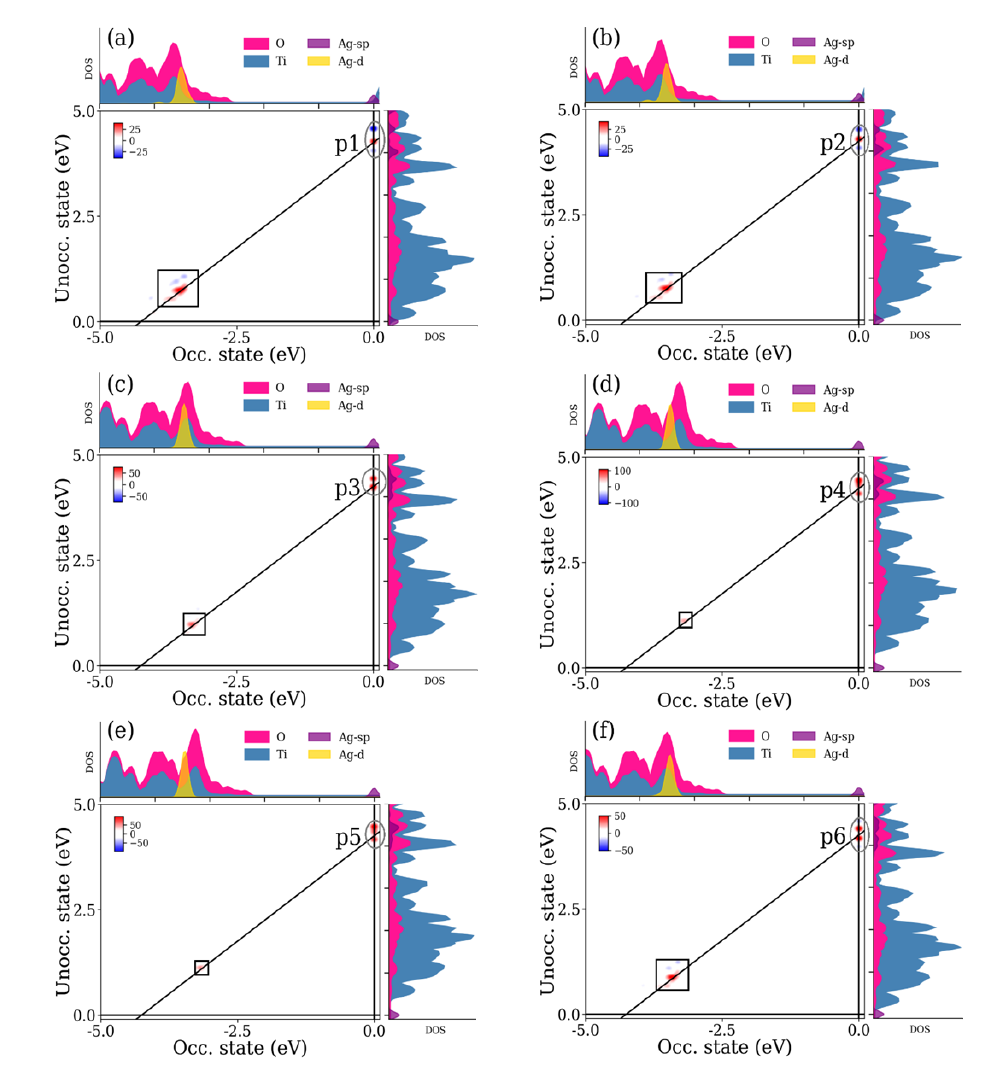
Figure 5. TCM of deposited Ag Me s for the suspended Me s at p1 ( a ), p2 ( b ), p3 ( c ), p4 ( d ), p5 ( e ), and p6 ( f ) positions. The diagonal solid lines are used to emphasize the constant transition energy at 4.25 eV. Bare TiO 2 contributions (square) can be found in the Supplementary Materials